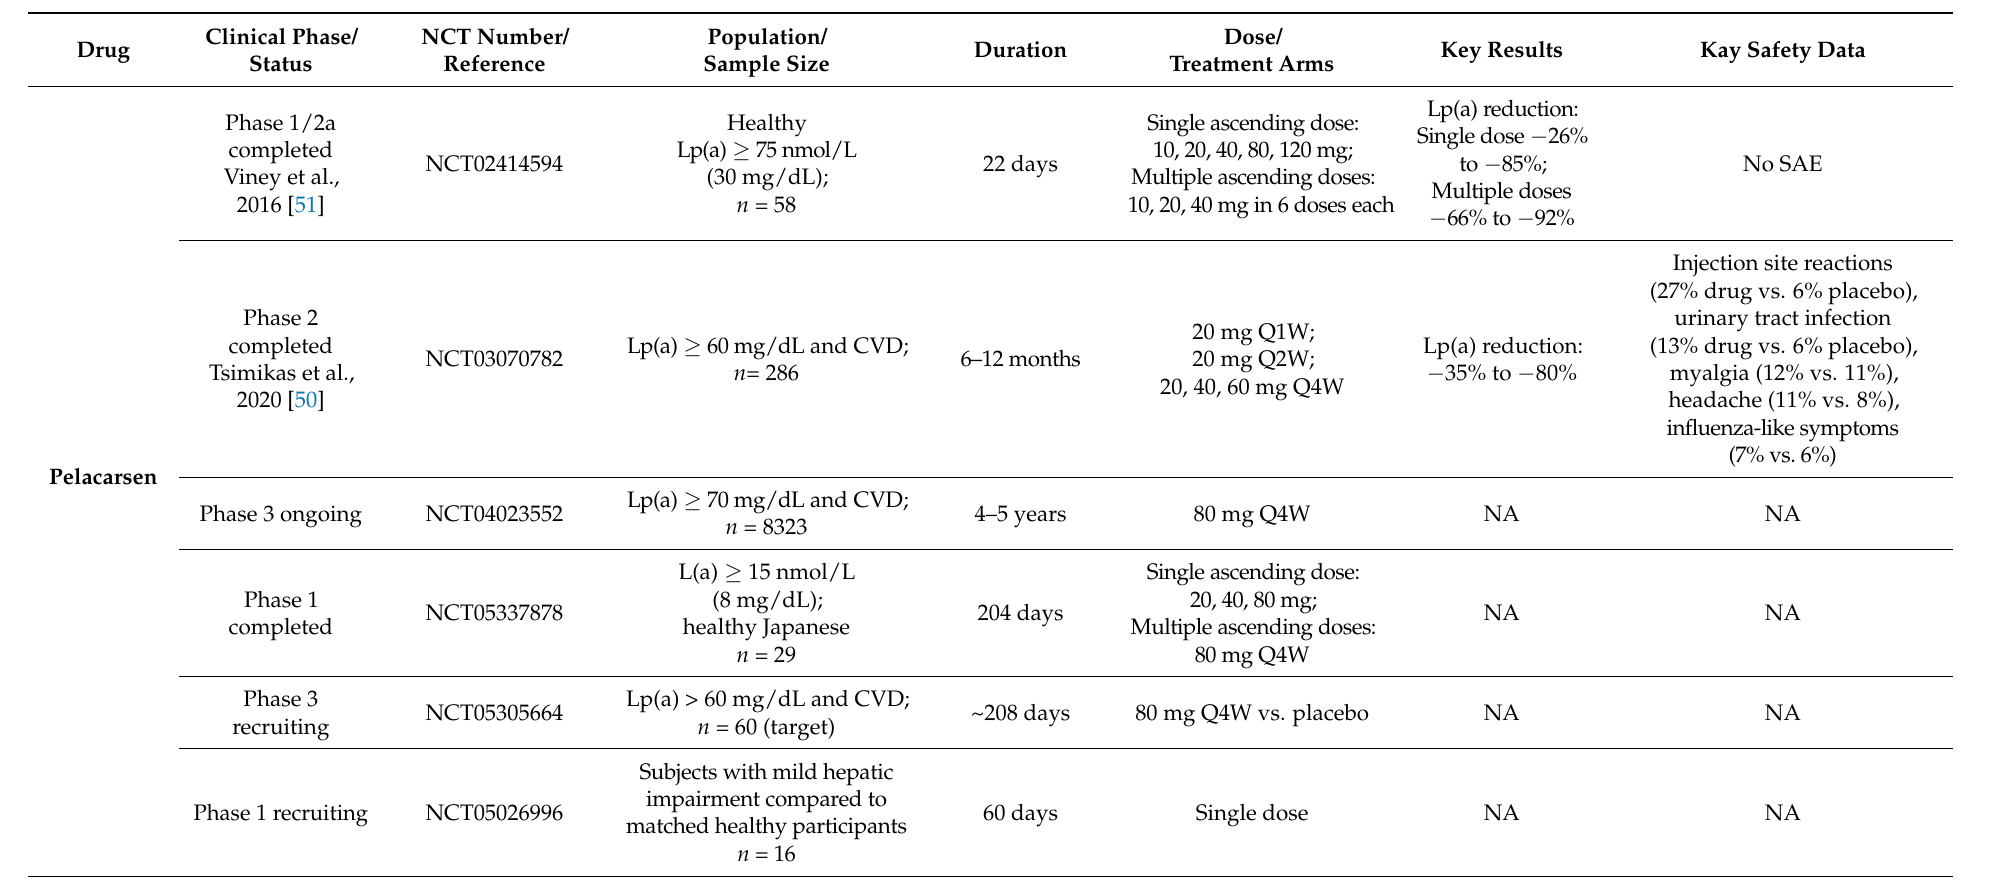
Table 5. Summary of the results of clinical trials with emerging Lp(a) lowering